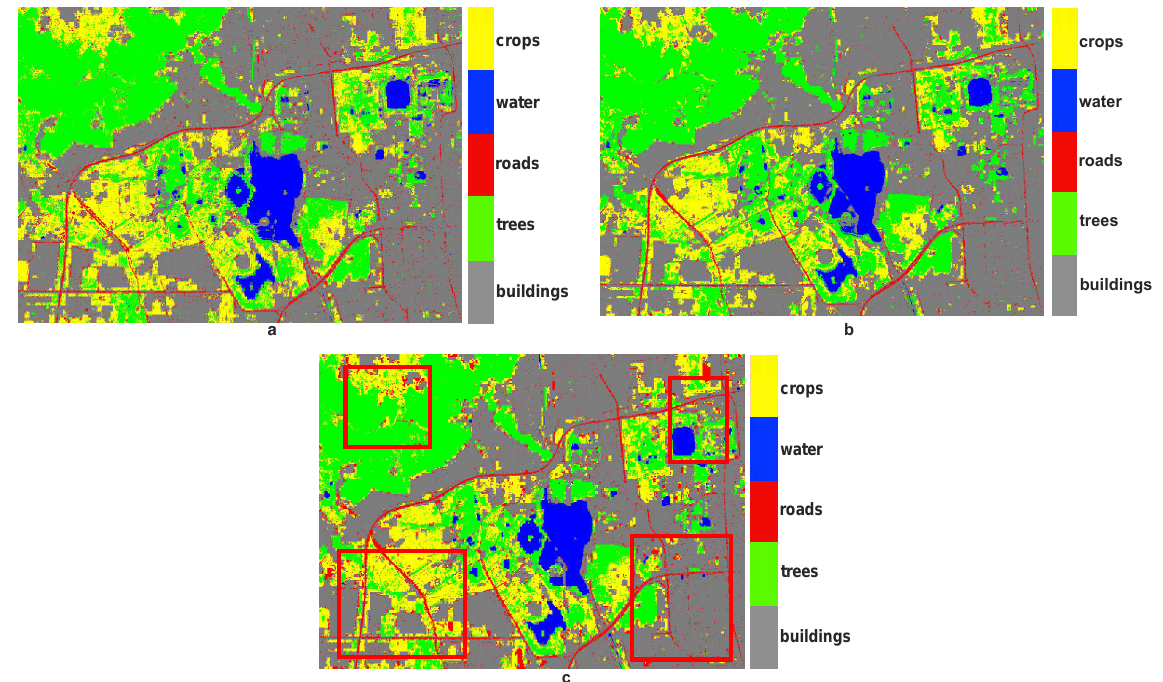
Figure 12. Classification maps using different trained models to the original image: ( a ) SVM; ( b ) conventional RF; ( c ) RF with Bayesian optimization (red rectangles mean obvious improvements for different regions among various